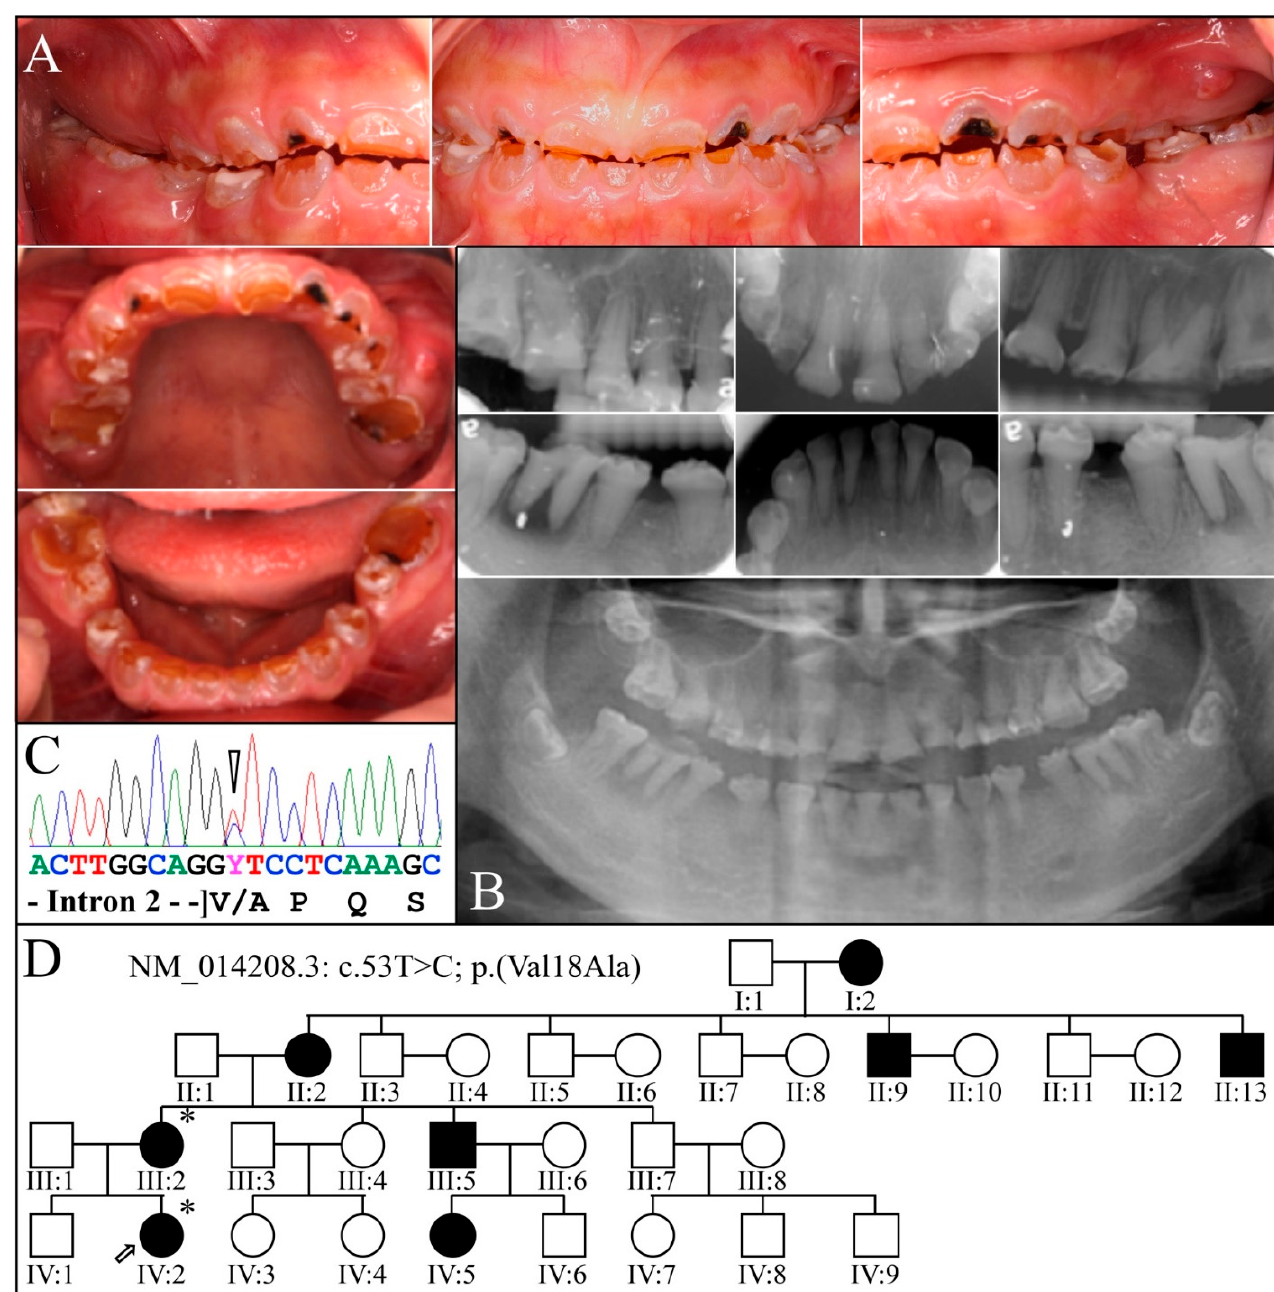
Figure 5. Family 3 from Taiwan. ( A ): Oral photos of the proband (IV:2) at age 12-years 1-month showing the severe attrition of the permanent dentition associated with first molar abscesses and loss of vertical dimension. This is a severe, DGI-III phenotype. ( B ): Proband ′ s radiographs, ( C ): Chromatogram demonstrated c.53T>C change, ( D ): Family pedigree . Key : * denotes enrolled participants.